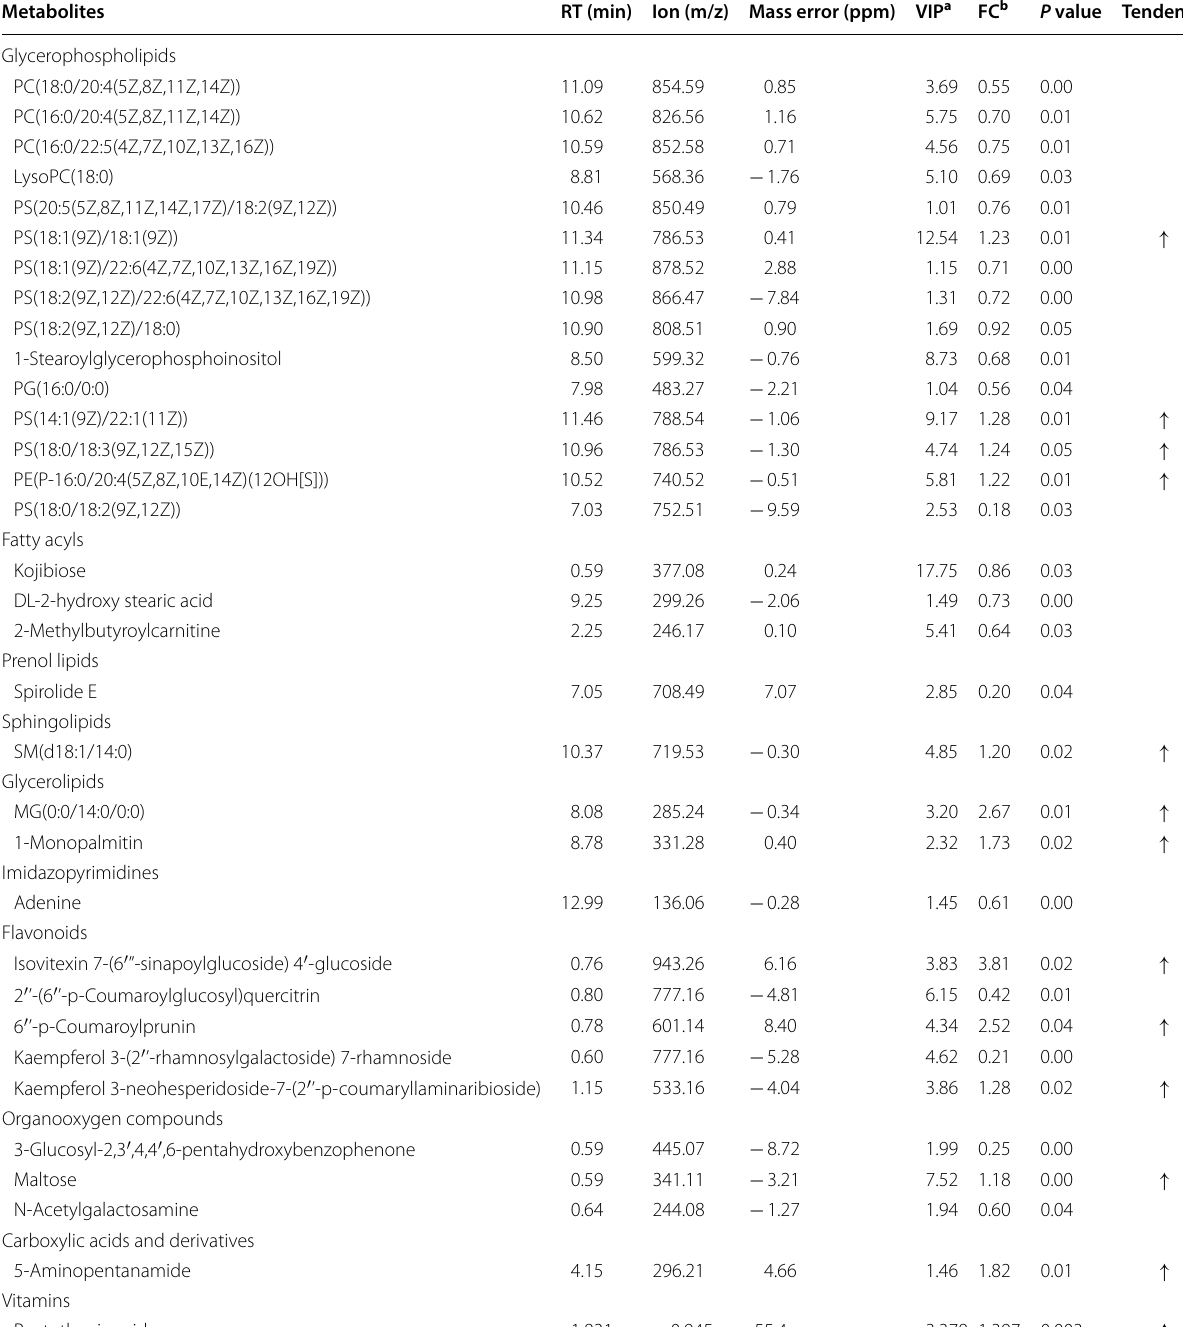
Table 4 Identification of significant differential metabolites in milk from lactating cows fed TMR supplemented with 0 (CON) and 120 g/d artemisinin (ART), n =